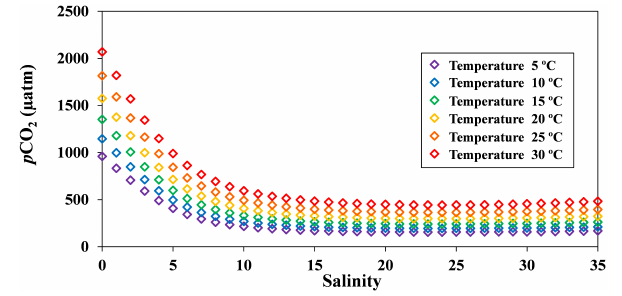
Figure 2. Simulated surface water p CO 2 against salinity grouped by temperature bins. Surface water p CO 2 values were calculated using river and ocean end-member TA and DIC values of 900 and 960µmolkg − 1 and 2300 and 2000µmolkg − 1 ,